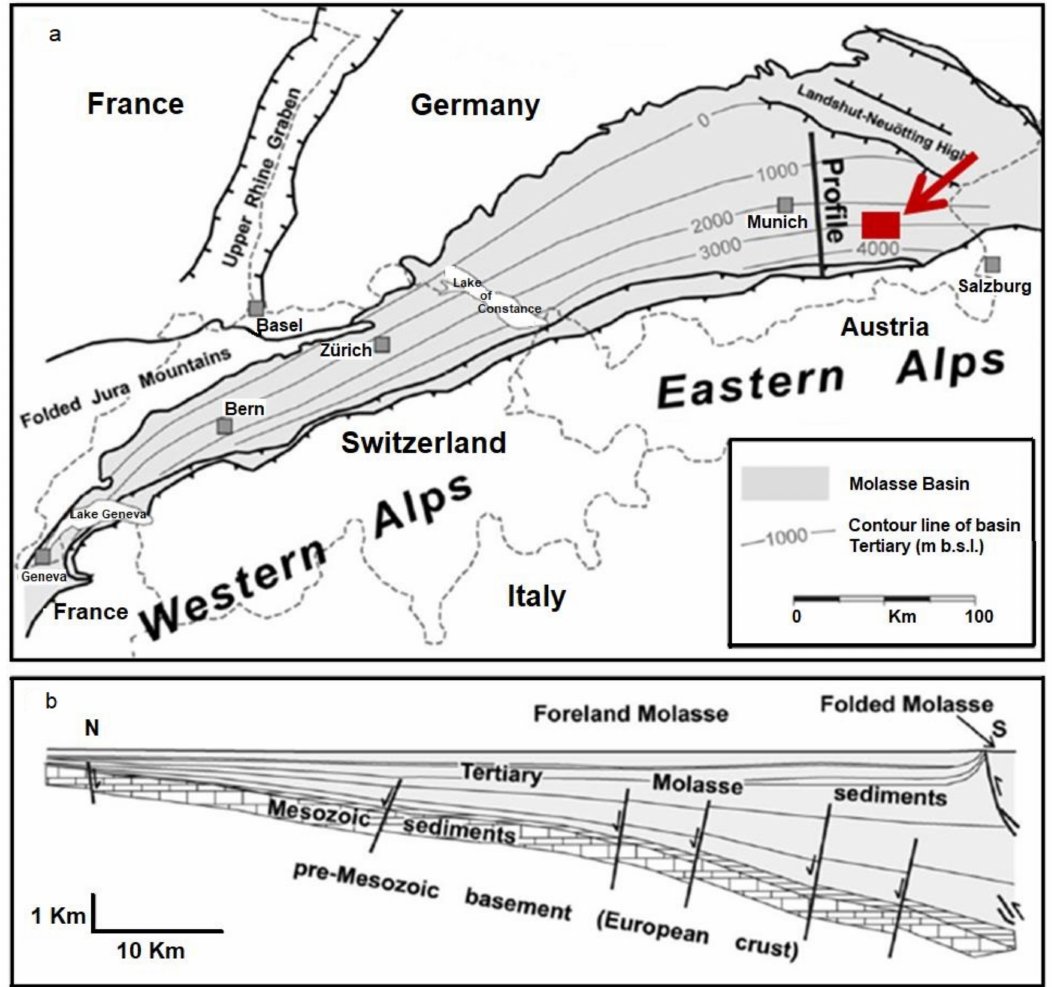
Figure 4. ( a ). Map of the Swiss-German Molasse basin along with main geological structures. Contour lines indicate the depth of the base of the Cenozoic sediments [4]. The grey area represents the Molasse Basin proper. The study area is indicated in red box. ( b ). N-S cross section of the profile in diagram A representing the subsurface structures [4]. The case study reservoir is located at one of the north-dipping normal faults. Reprint with permission [Reinecker et. al], 2010,